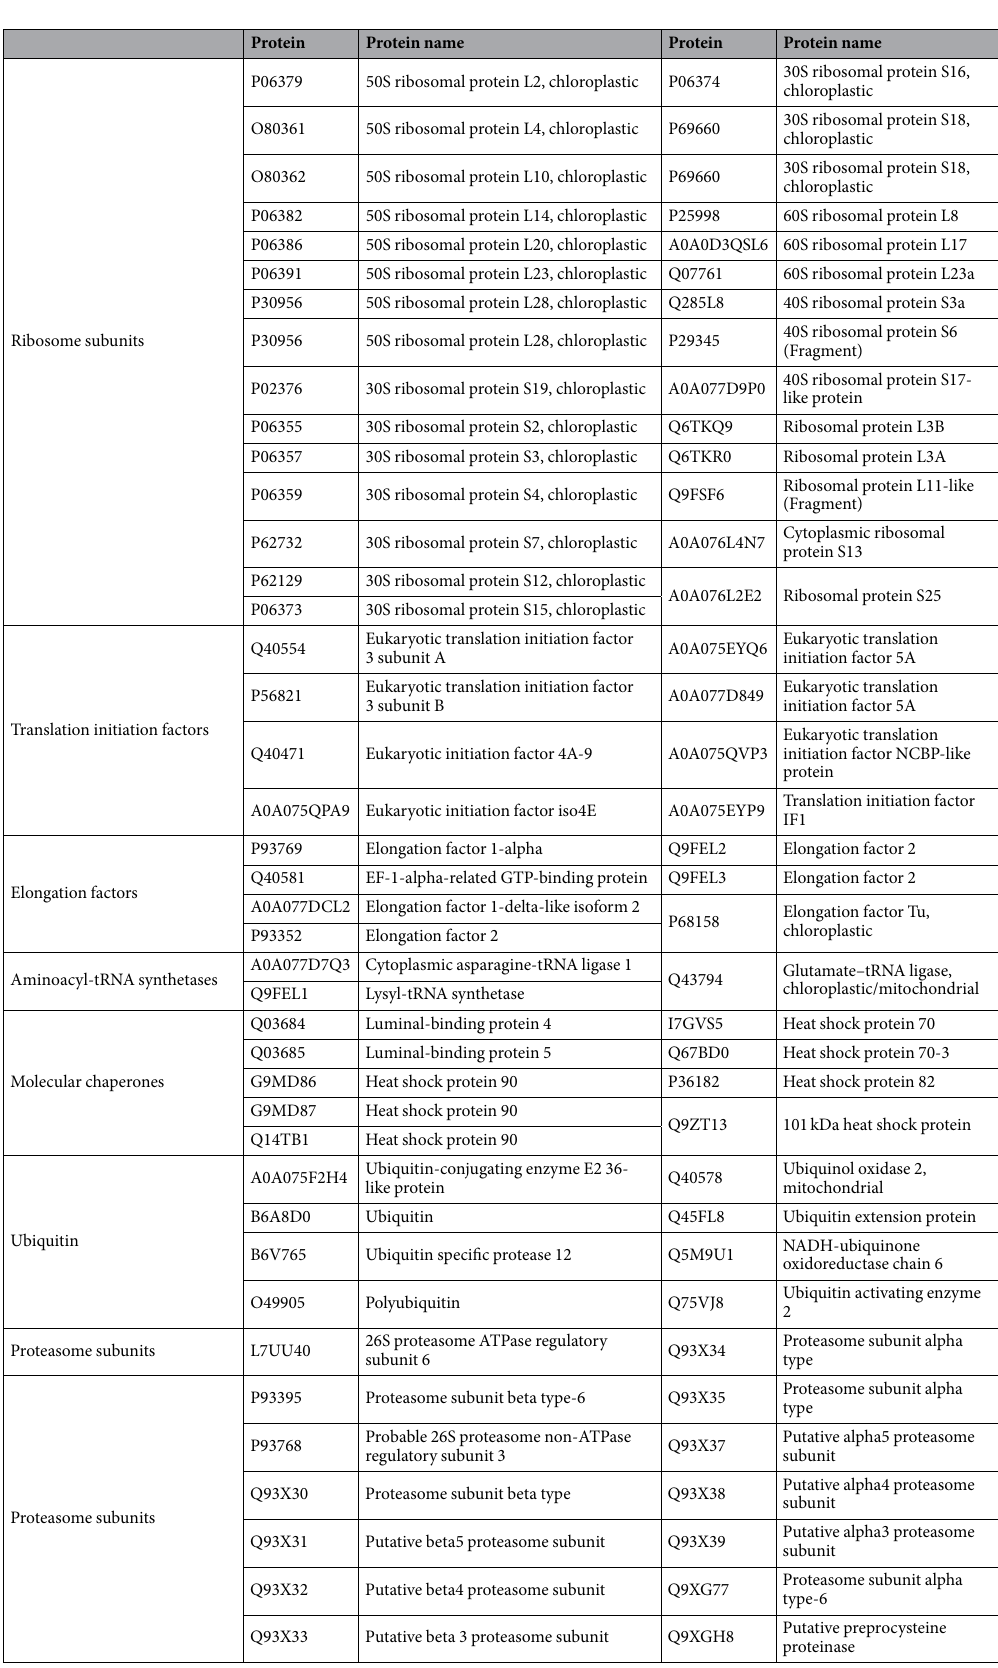
Table 3. Crotonylated proteins involved in protein biosynthesis, folding, Ubiquitin-dependent